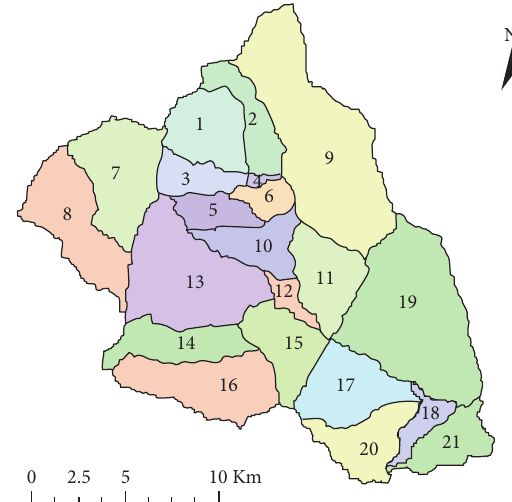
Figure 3: Spatial distribution of Kulfo subwatersheds and its sediment yield.